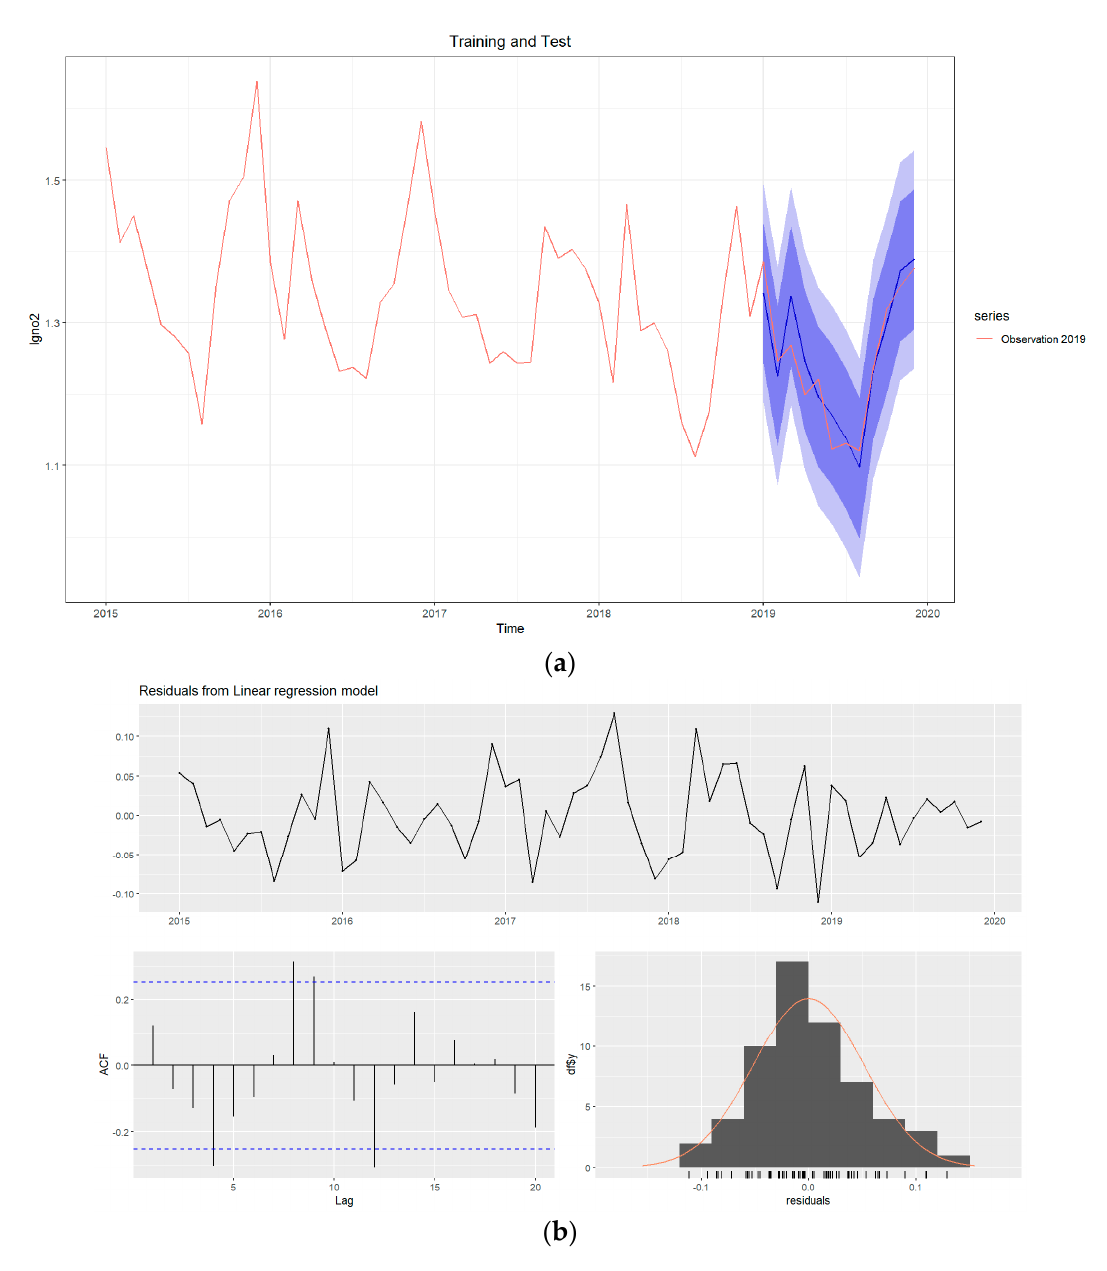
Figure 7. Model performance assessment results and the residuals analysis of the time-series multi- linear regression prediction model. ( a ) The validation results in terms of using the data for 2015–2018 for training and the 2019 observation data for comparison. ( b ) A time plot, the ACF, and the histogram of the residuals from the multiple regression model fitted to the NO 2 data, as well as the Breusch–Godfrey test for jointly testing up to 16th-order autocorrelation. The histogram shows that the residuals seem to be slightly skewed, which may also reflect the coverage probability of the prediction